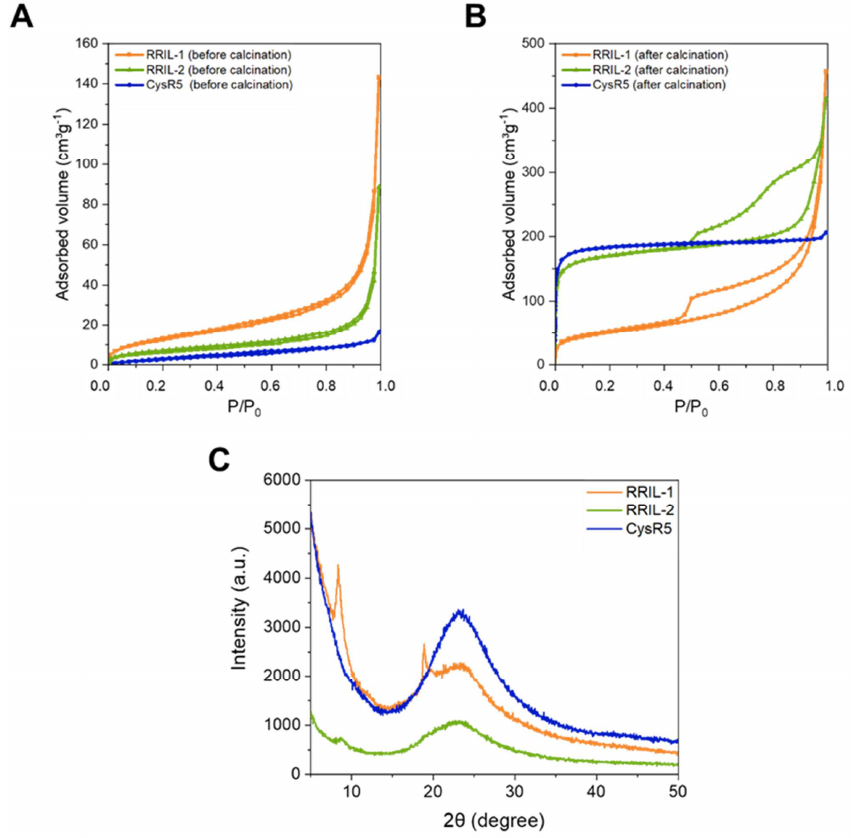
Figure 7. Nitrogen physisorption isotherms measured at −196 °C of CysR5 (blue), RRIL-1 (orange) and RRIL-2 (green) silica particles before ( A ) and after ( B ) calcination. Wide-angle powder XRD patterns ( C ) of CysR5 1′ (blue), RRIL-1 2′ (orange), and RRIL-2 3′ (green) silica particles. Table 3. Physicochemical properties of the silica-based particles obtained from nitrogen adsorption (−196 °C) before and after calcination.